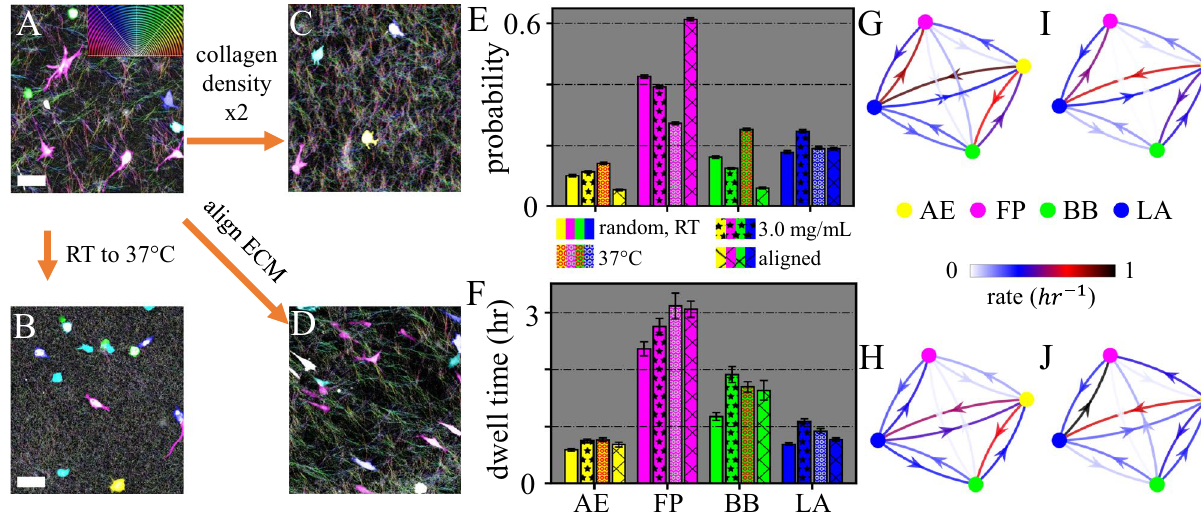
Figure 4. Physical properties of collagen ECM regulate the morphological phenotype homeostasis of 3D migrating MDA-MB-231 cells. ( A – D ) Confocal reflection images and pseudo colored MDA-MB-231 cells for collagen matrices prepared at varying conditions. Scale bars: 20 µ m. A Collagen ECM prepared at room ◦ temperature (RT, or 25 C) and collagen concentration of [ col ] = 1.5 mg/mL. B Collagen ECM prepared ◦ at 37 C and [col] = 1.5 mg/mL. C Collagen ECM prepared at RT and [ col ] = 3.0 mg/mL. D collagen ECM prepared with flow-aligned collagen fibers. ( E ) Fraction of cells in each morphological phenotype. 8000 single cell images are analyzed under each ECM condition. ( F ) Dwell time of cells in each morphological phenotype. Errorbars in ( E, F ) represent 95% confidence intervals calculated from 1000 bootstrap iterations. ( G – J ) The transition matrix—morphological phenotype transition rates under varying ECM conditions. G Collagen